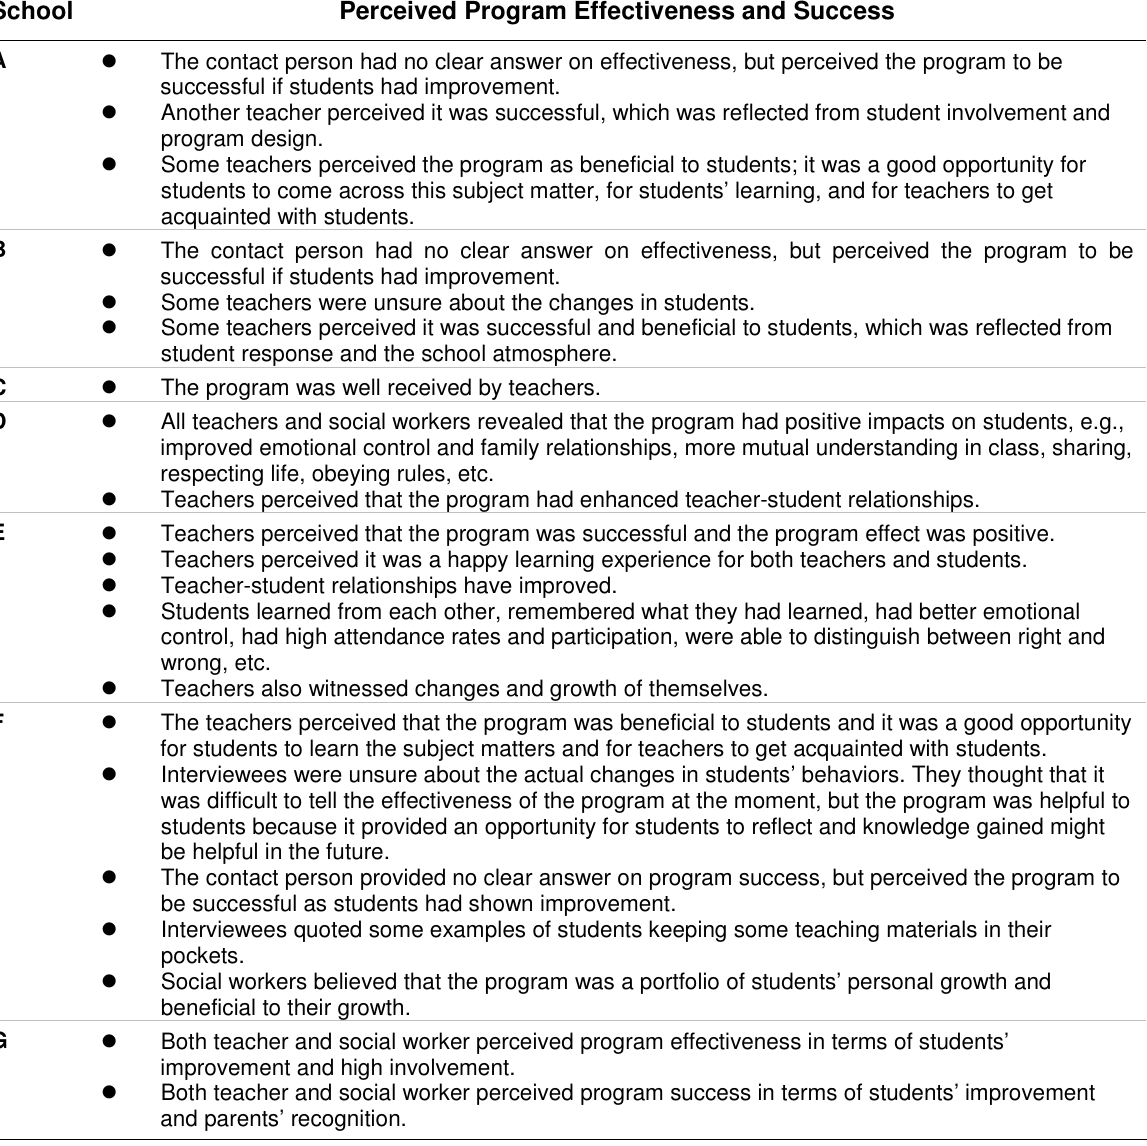
Perceived Program Effectiveness and